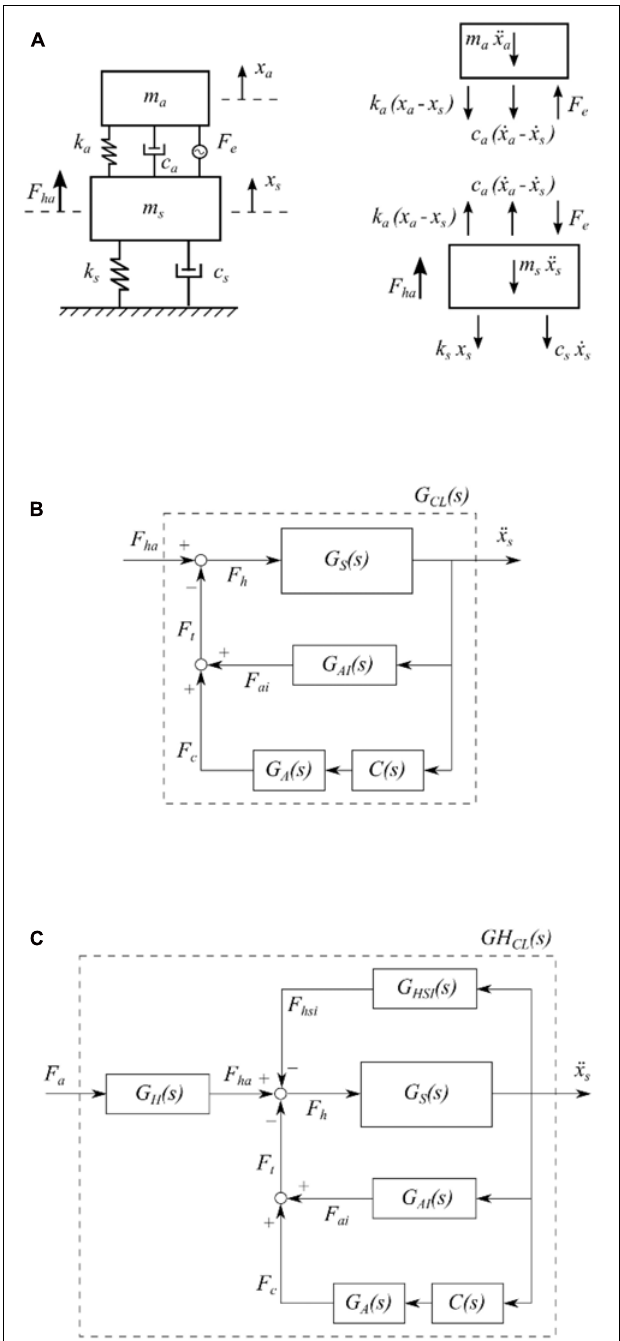
FIGURE 3 | AVA system: (A) Free body diagram, (B) Block diagram of the plant with an AVA, and (C) Block diagram of the plant with an AVA and